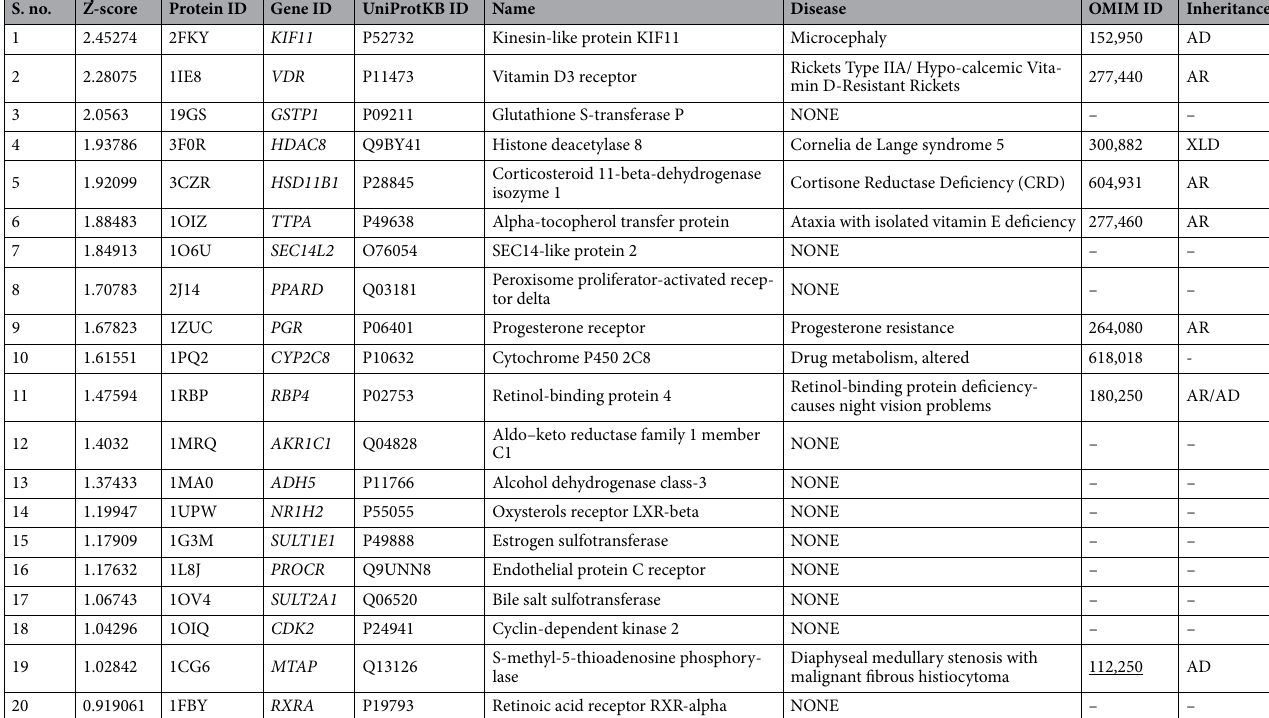
Table 2. Top twenty targets of Xanthorrhizol predicted by PharmMapper and DRAR-CPI serv. AD; autosomal dominant, AR; autosomal recessive, XLD; X-linked